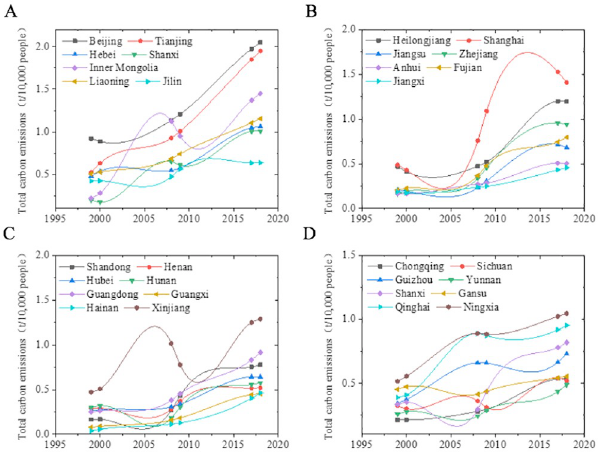
Fig 5. Total carbon emissions in different years in different